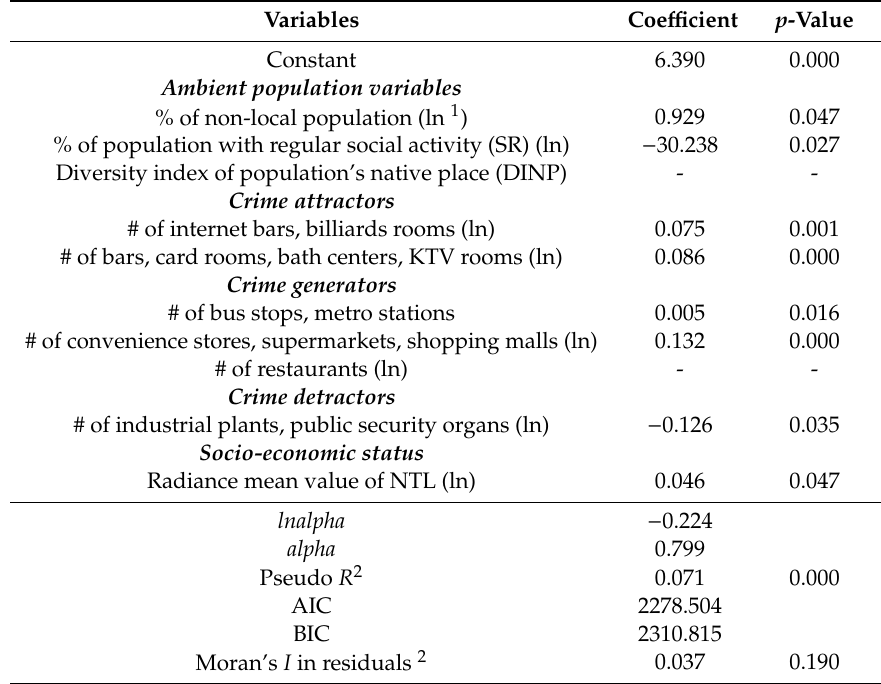
Table 3. Parameter estimates from the negative binomial model (N = 187